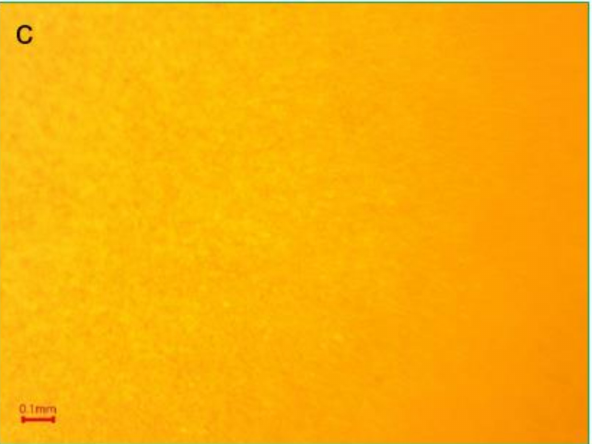
Figure 3. ( a ). The optical photos of WF emulsion; ( b ). CF emulsion; ( c ). FB emulsion.